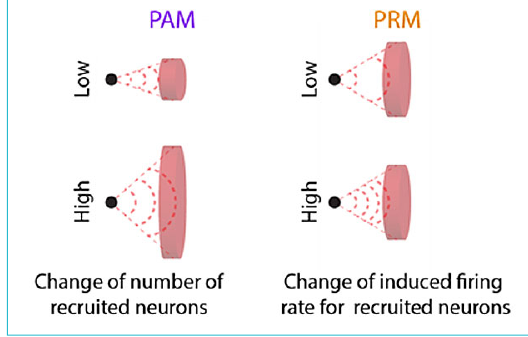
Figure 4: Illustration of the effect of the different modulation modes. Amplitude modulation (i.e., current intensity) modulates the size of the area stimulated (PAM, left panel). Rate modulation (i.e. repetition frequency of stimulation pulses) modulates the firing rate of the target afferent nerve (PRM, right panel). Reproduced with permission of IOP Publishing from: Nguyen TAK, DiGiovanna J, CavuscensS, RanieriM, GuinandN, van de Berg R, et al. Char- acterization of pulse amplitude and pulse rate modulation for a hu- man vestibular implant during acute electrical stimulation. J Neural Engeneering. 2016; 13 046023, permission conveyed through Copyright Clearance Center,